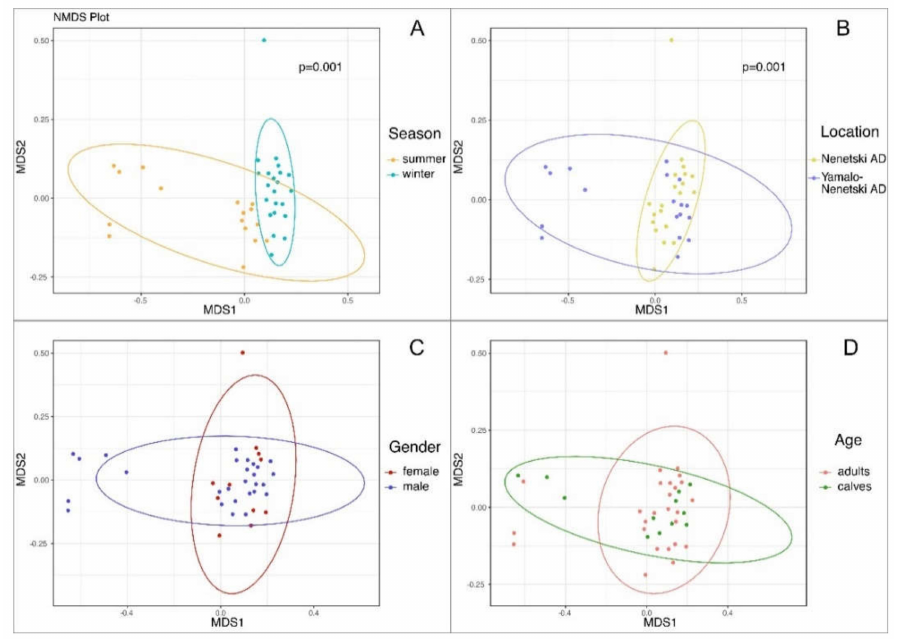
Figure 6. Non-metric multi-dimensional scaling (NMDS) of the samples from different seasons ( A ), regions ( B ), sexes ( C ), and ages ( D